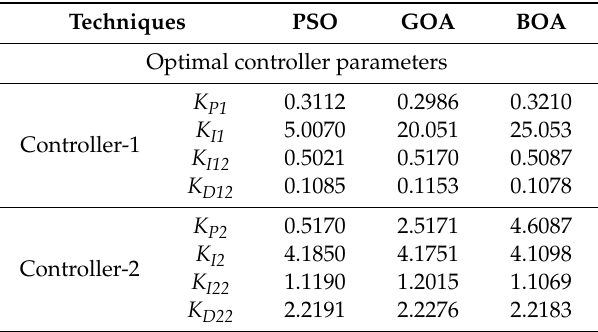
Table 3. Optimal values of particle swarm optimization (PSO), grasshopper algorithmic technique (GOA) and BOA techniques tuned PI-(1 + ID)